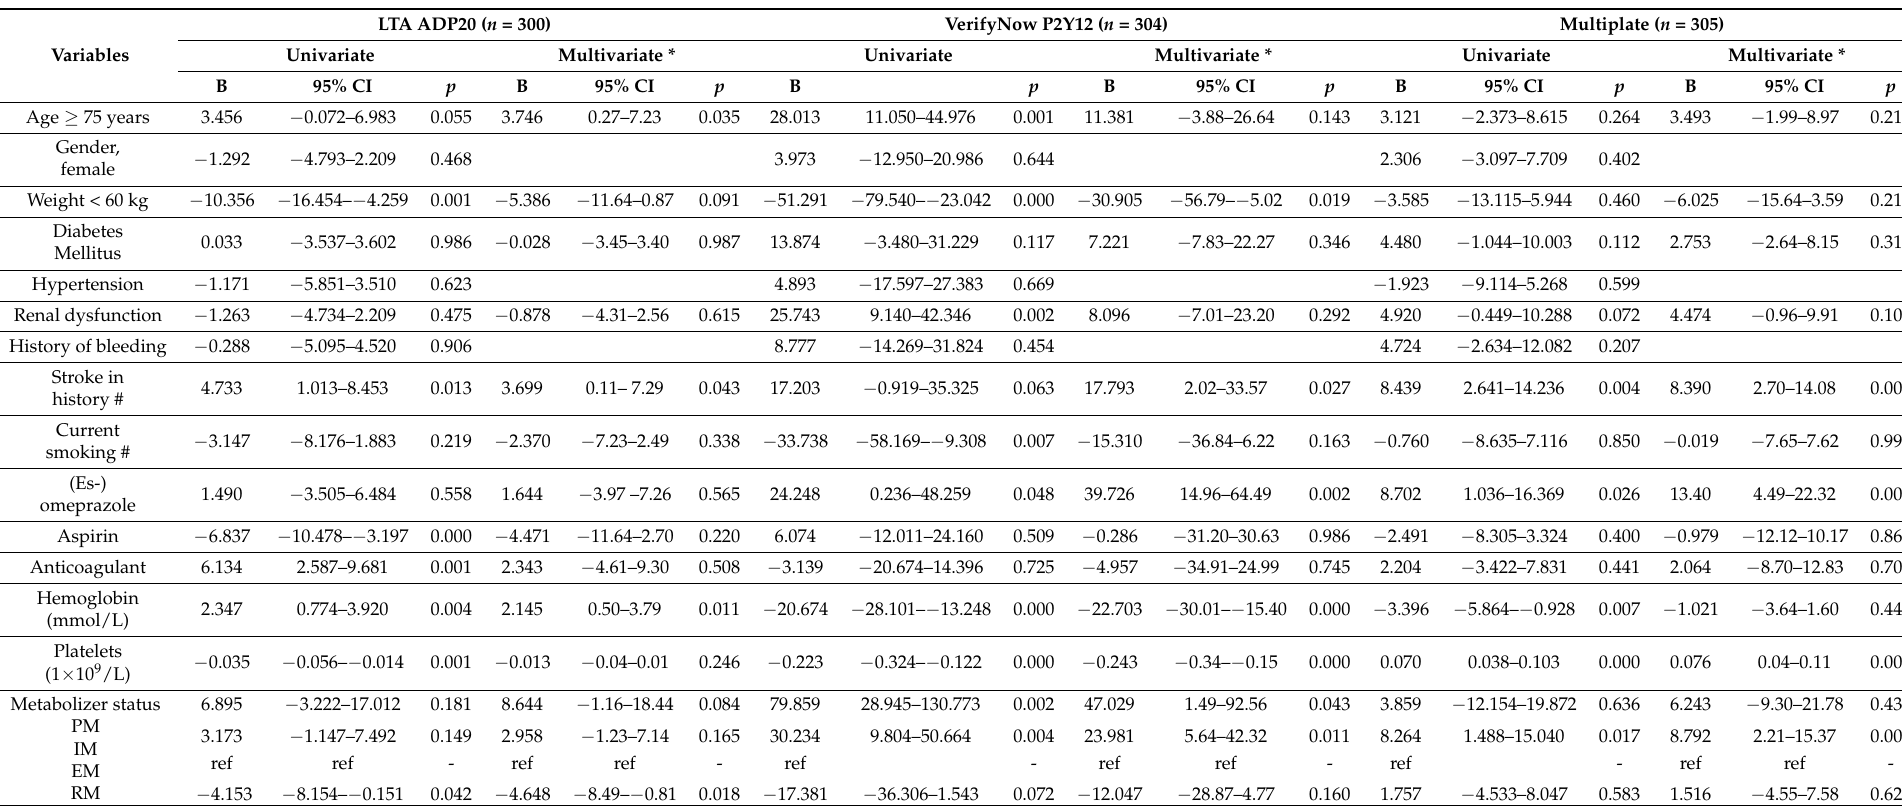
Table A2. Partial regression coefficients of variables for LTA, VerifyNow, and Multiplate in univariate and multivariate